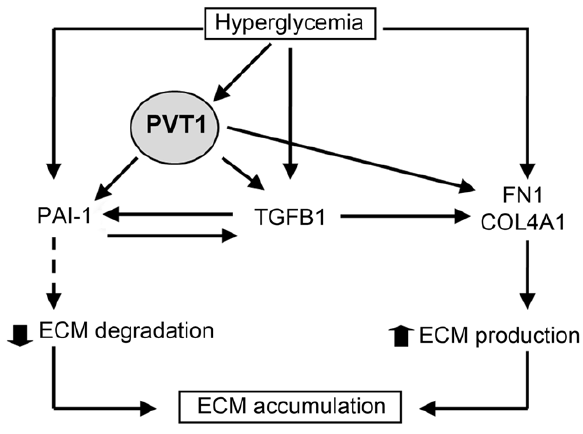
Figure 5. Potential mechanism for PVT1 involvement in ECM deposition. Hyperglycemia causes an excessive accumulation of